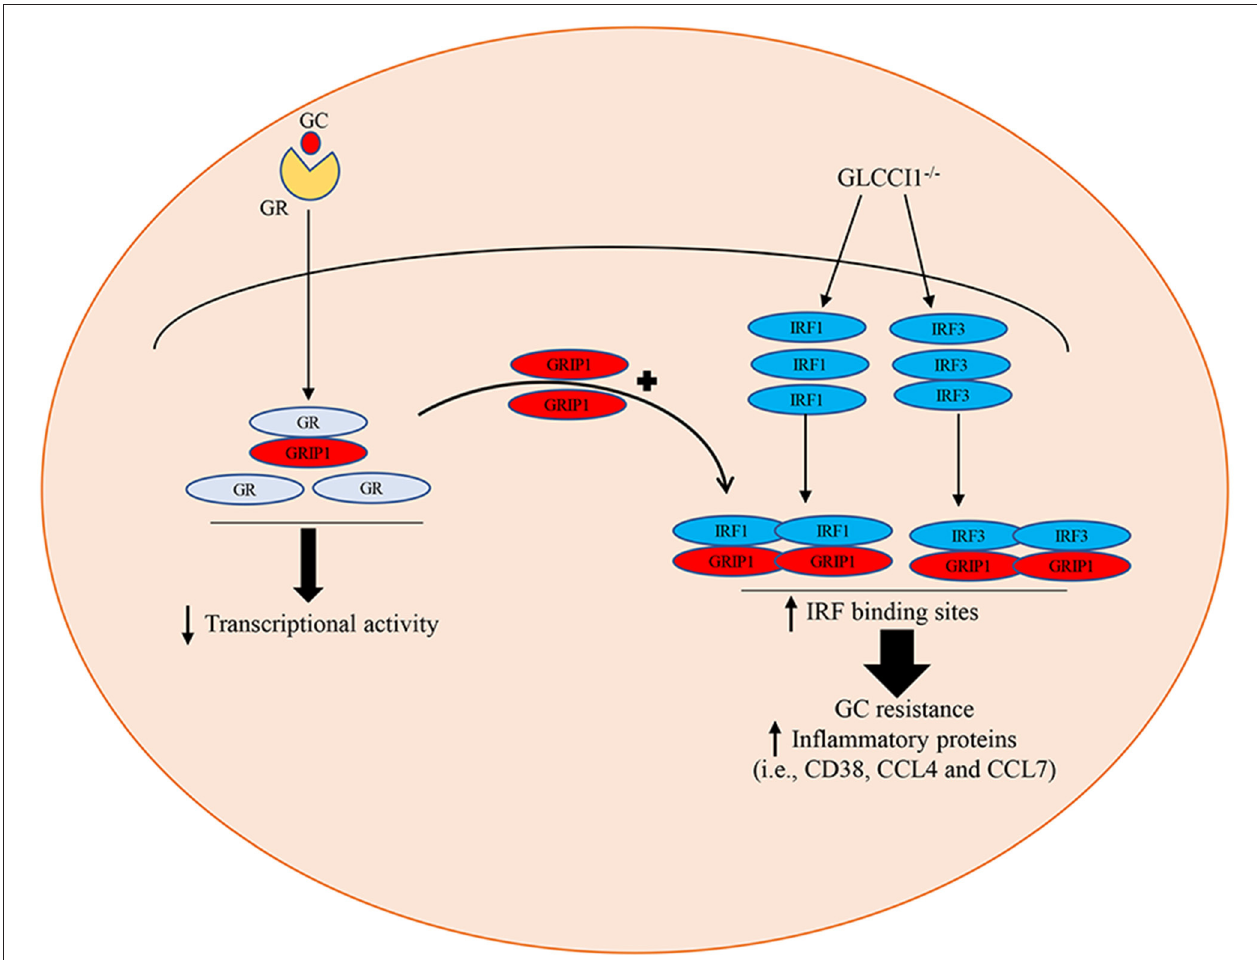
FIGURE 7 | Schematic summary of the role of GLCCI1 in GC-treated OVA-induced asthma. GLCCI1 expression on epithelial cells in GC responses in asthma by which GLCCI1 deficiency reduces the GR and GRIP1 interaction but competitively enhances the recruitment of GRIP1 to IRF1 and IRF3.